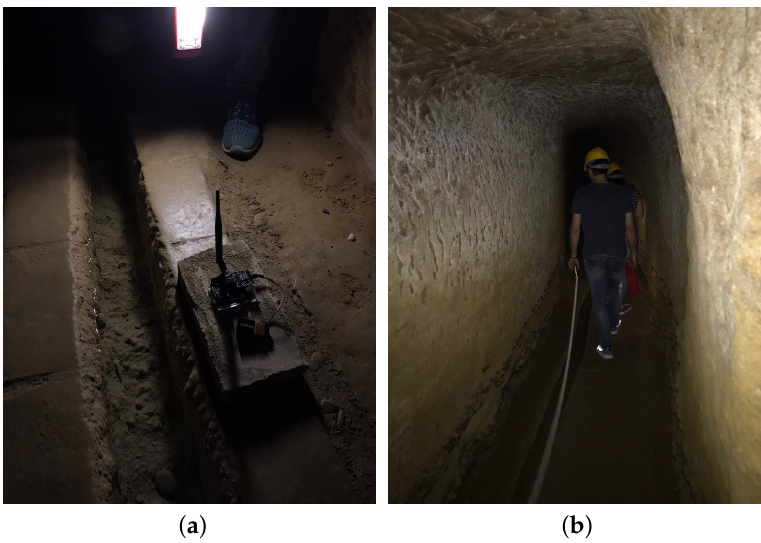
Figure 3. ( a ) The LoRa transmission module and ( b ) the data transmission range measurement